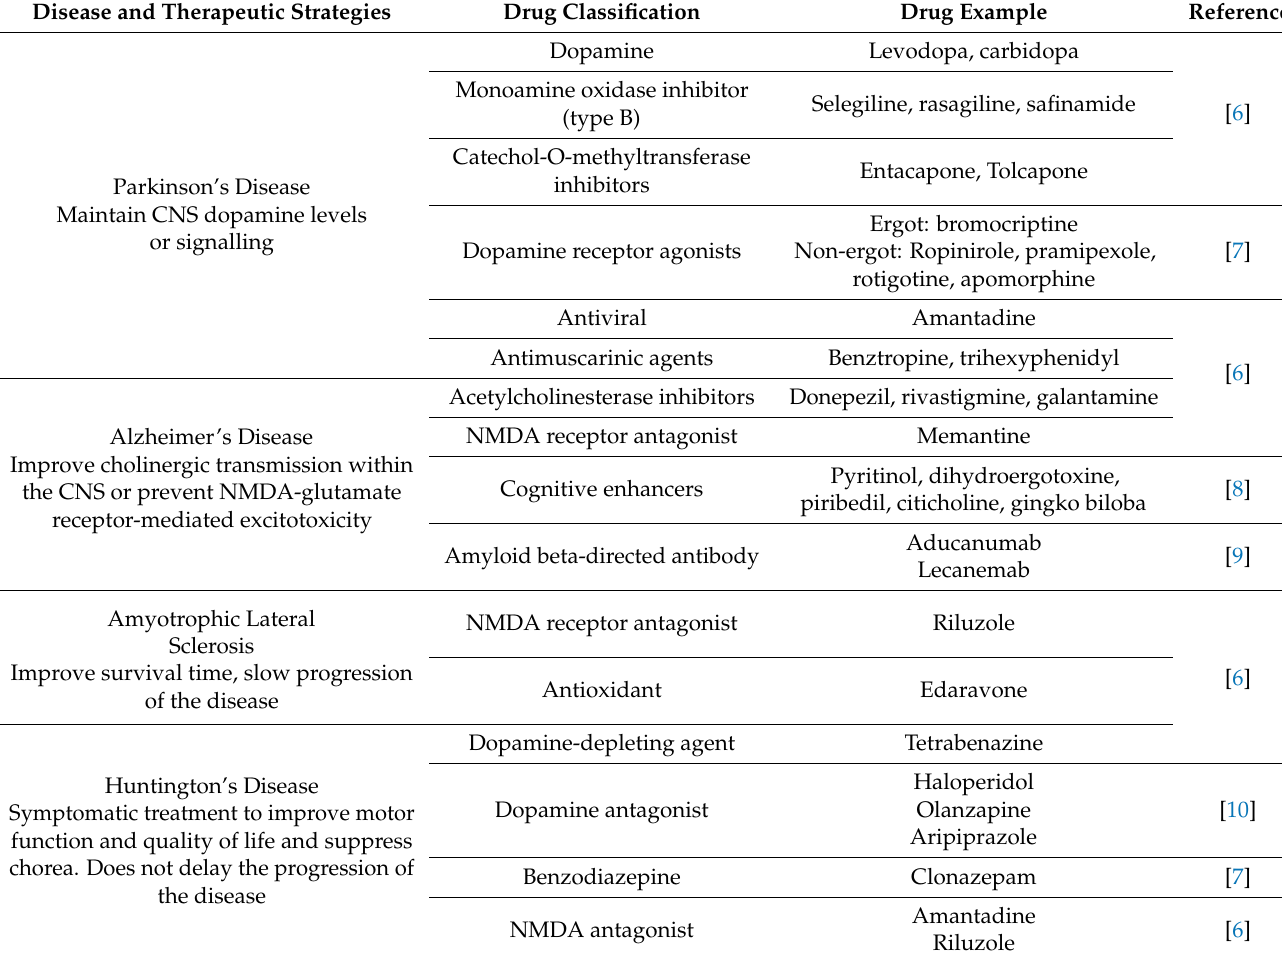
Table 1. Currently available drugs for neurodegenerative diseases. Disease and Therapeutic Strategies Drug Classification Drug Example